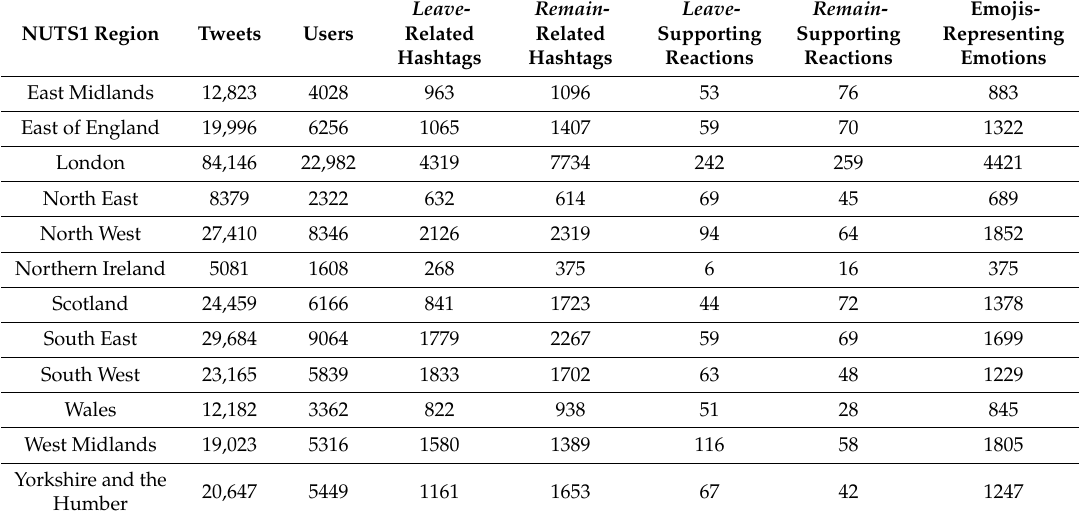
Table 3. Basic statistics for each NUTS1 region in the UK.